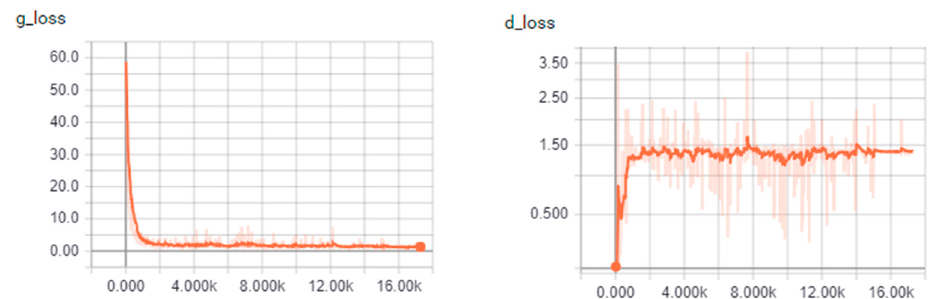
Figure 7. Convergence curves of the discriminator and generator. Both g-loss and d-loss converge quickly after approximately 1000 steps.